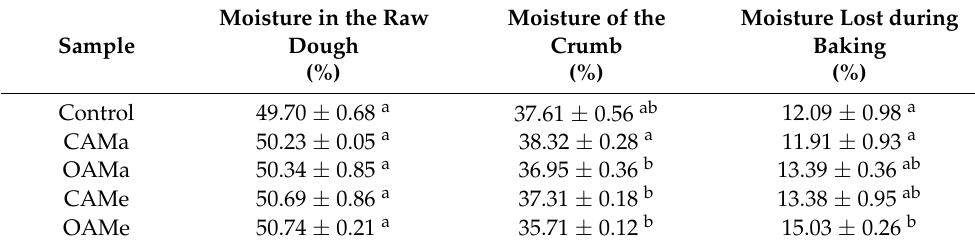
Table 3. Percentage of moisture in the raw dough and moisture lost during baking.